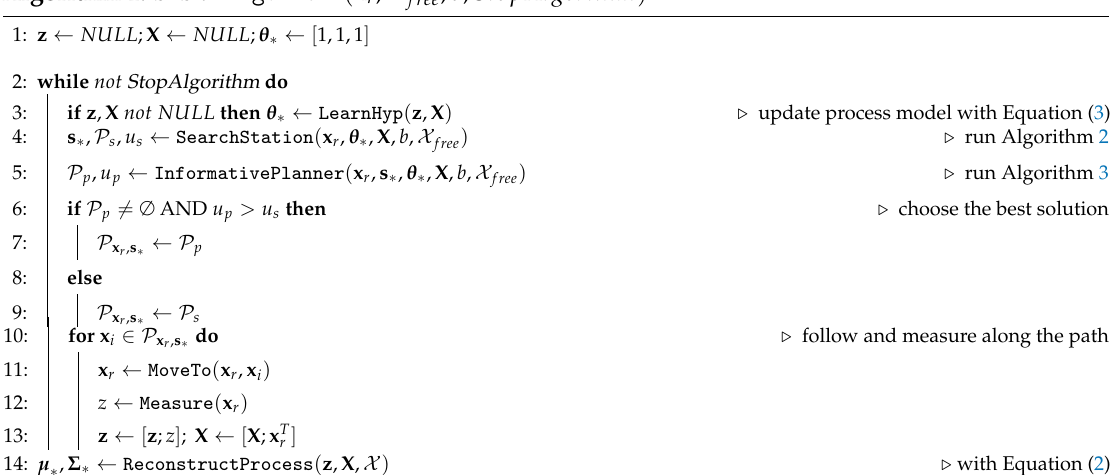
Algorithm 1. SBSRE Algorithm ( x r ,